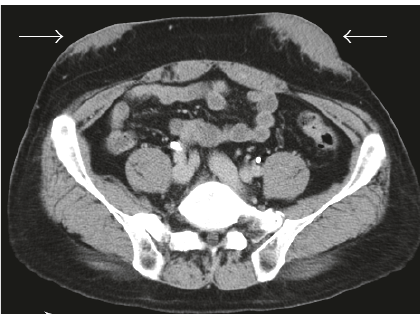
Figure 2: Contrast-enhanced CT of the abdomen (equilibrium phase): in the left and right subumbilical regions, subcutaneous masseswithirregularmarginsareobserved,eachmeasuringapprox- imately 60 mm. The density is heterogeneous and higher than that of the surrounding adipose tissue, without contrast-enhancement effect (indicated by arrows).